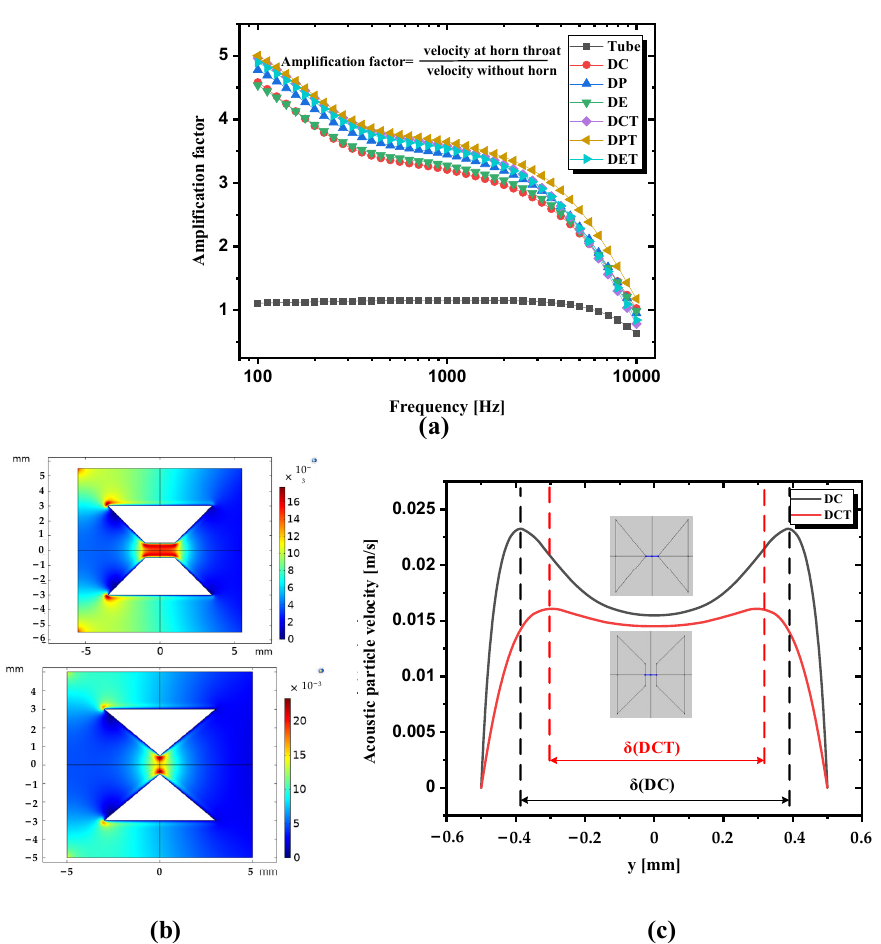
Figure 6. ( a ) Frequency responses of the velocity amplification factor for different kinds of acoustic horns. The amplification factor is defined by the ratio of acoustic particle velocity at the horn throat and velocity without the horn; ( b ) Acoustic particle velocity distribution of the DCT horn and DC horn; ( c ) Velocity distribution along the y -axis at the DCT horn throat and DC horn